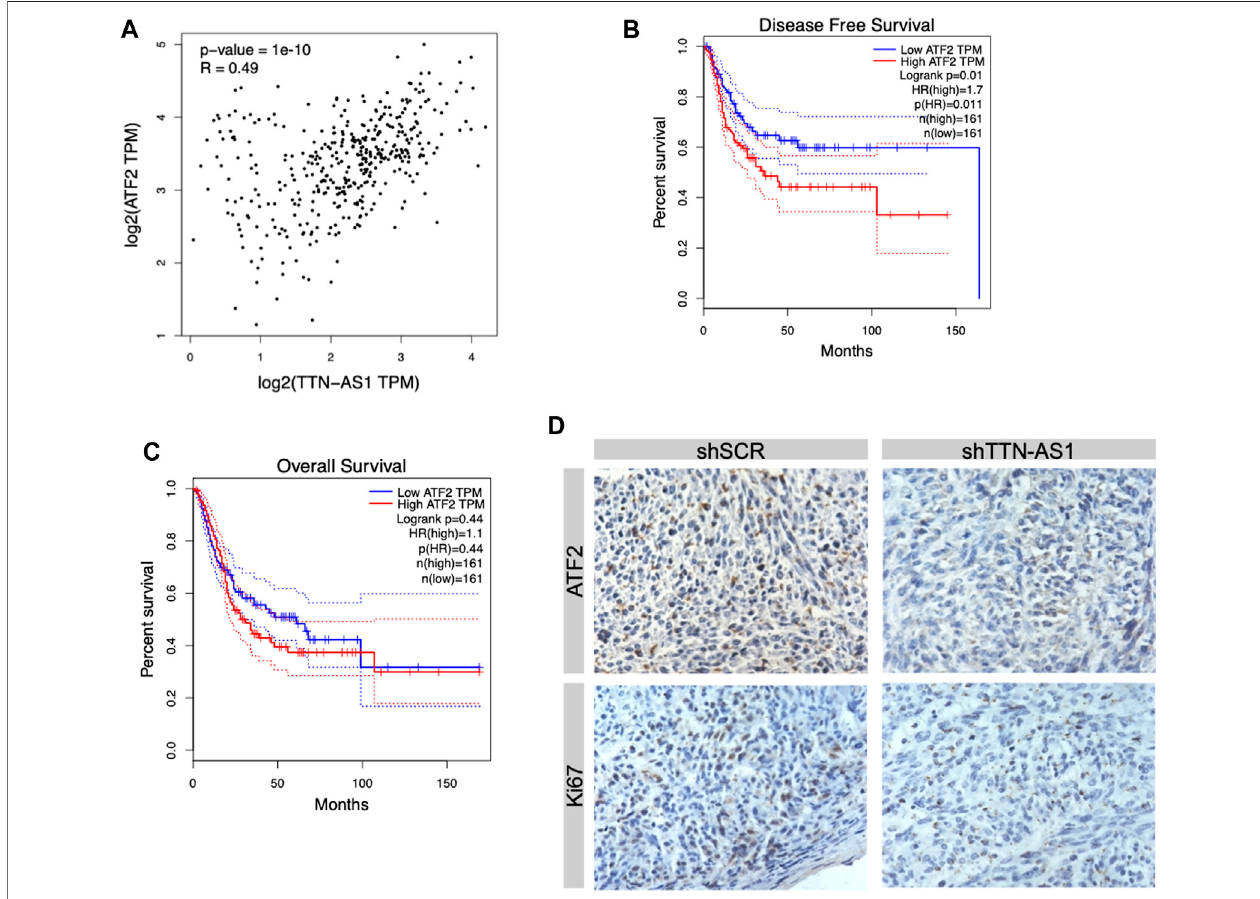
FIGURE4| ATF2wasthe downstream factor oflncRNATTN-AS1and wasrelatedtopoorprognosisin BCpatients. (A) Bioinformaticswasconducted toanalyze the correlation between lncRNA TTN-AS1 and ATF2. (B) The DFS of BC patients from TCGA database ( n (cid:1) 322, p (cid:1) 0.011) (C) The OS of BC patients from TCGA database ( n (cid:1) 322, p (cid:1) 0.44) (D) IHC was performed to explore the expression of ATF2 in both shSCR and shTTN-AS1